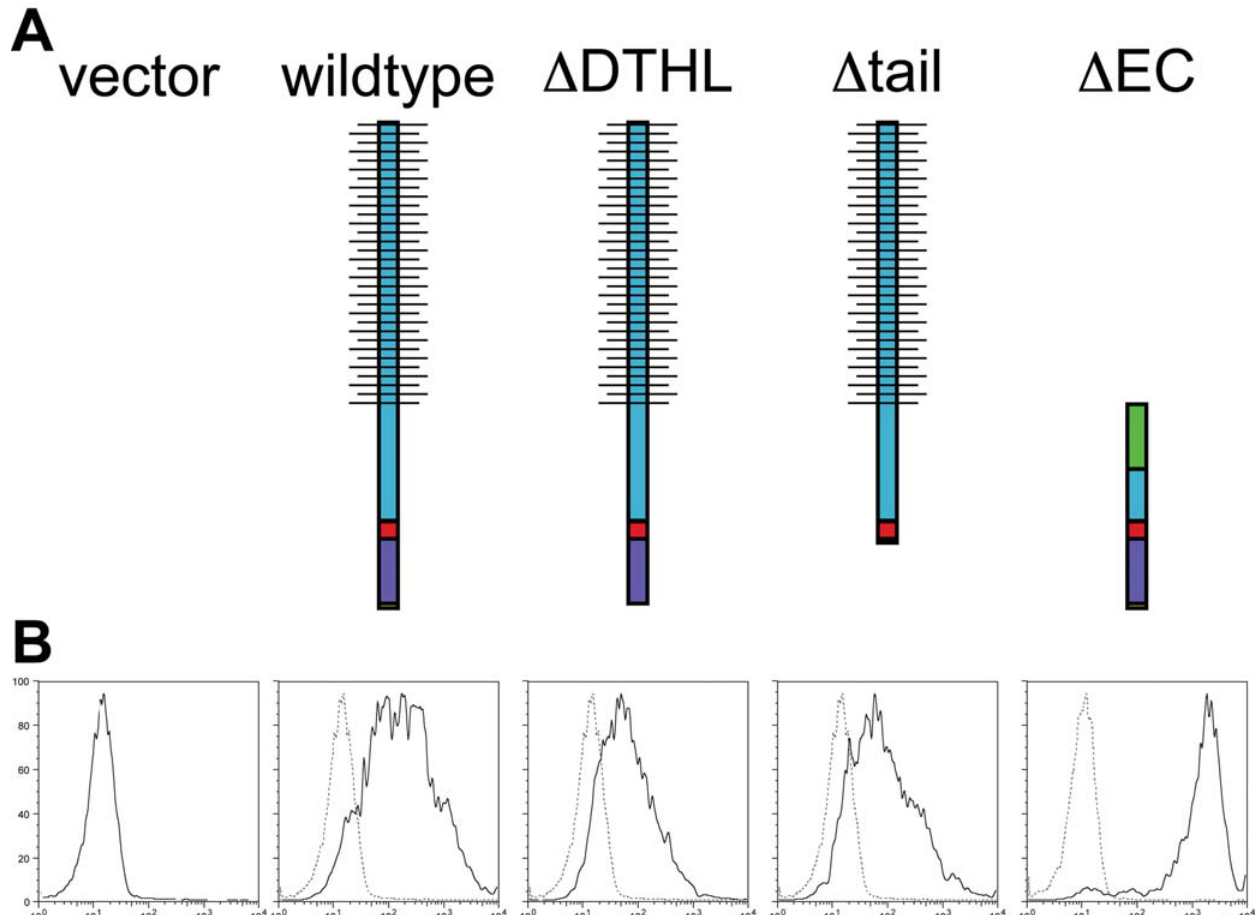
Figure 6. Schematic of Podocalyxin mutants and FACS expression profiles. (A) Podocalyxin mutants. Blue: extracellular domain, horizontal bars: carbohydrates/sialic acid residues, red: transmembrane region, purple: cytoplasmic tail (including C-terminal DTHL in wildtype and D EC), and green: flag-tag replacing most of Podocalyxin’s extracellular domain. (B) FACS profiles demonstrating comparable Podocalyxin expression levels in sorted clones. Dashed lines represent negative controls (vector-transfected cells stained with the same antibodies); solid lines represent Podocalyxin expression. Note: all mutants were detected with an anti-Podocalyxin antibody with the exception of D EC, which was detected with an anti-flag